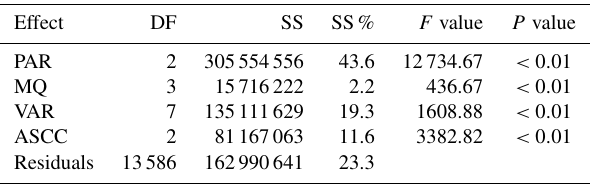
Table 4. Analysis of variance 1 for milk yield loss by somatic cell count